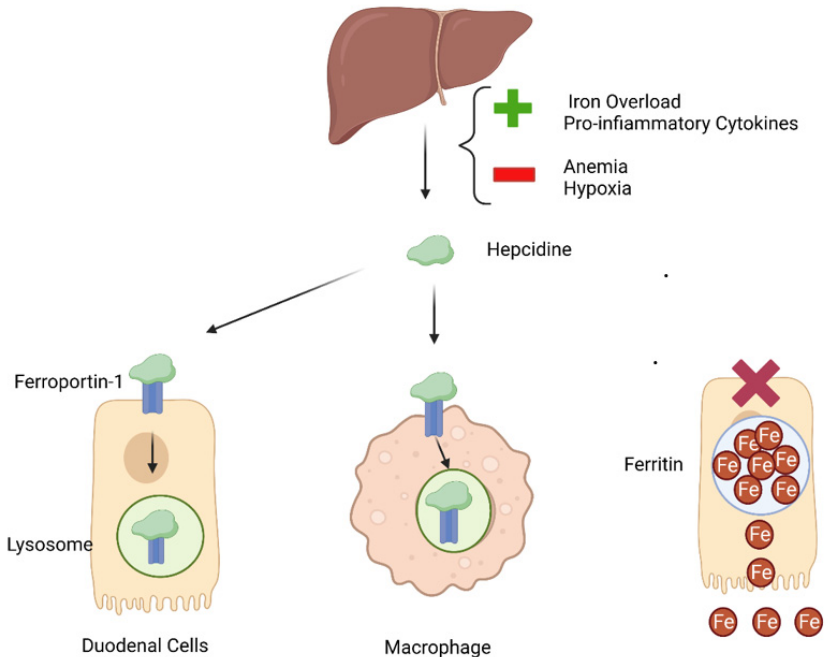
Figure 2. Inflammation effect on iron metabolism (created with BioRender.com (accessed on 15 Figure 2. In fl ammation e ff ect on iron metabolism (created with BioRender.com (accessed on 15 March 2023)). March